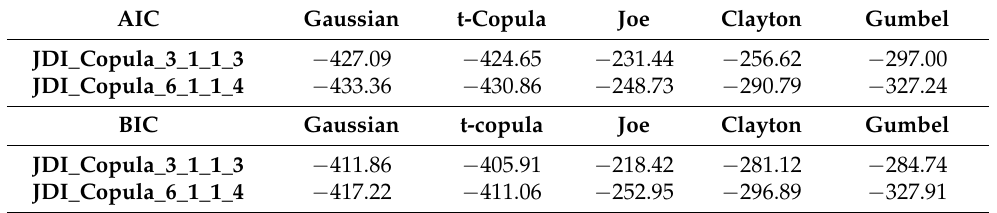
Table 3. Akaike information criterion (AIC) and Bayesian information criterion (BIC) statistics for different types of